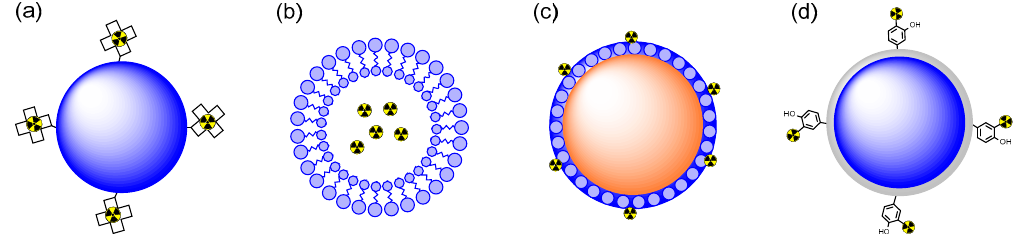
Figure 2. Incorporation of therapeutic radionuclides into the nanocarrier by ( a ) chelation, ( b ) Figure2. Incorporationoftherapeuticradionuclidesintothenanocarrierby( a )chelation, ( b )entrapment, entrapment, ( c ) sorption, and ( d ) covalent bonding. ( c ) sorption, and ( d ) covalent bonding.